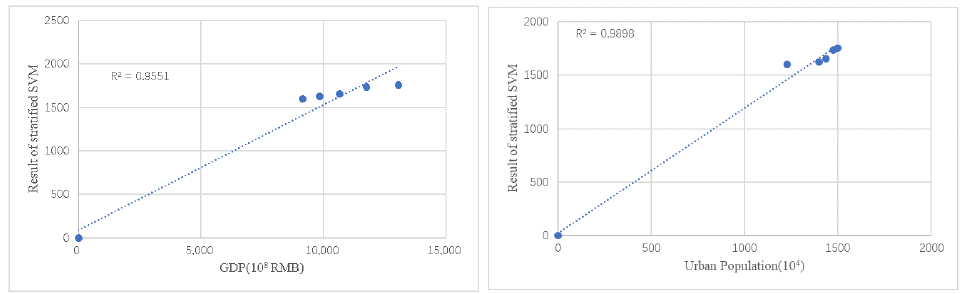
Figure 11. The correlation between built-up area and GDP/urban